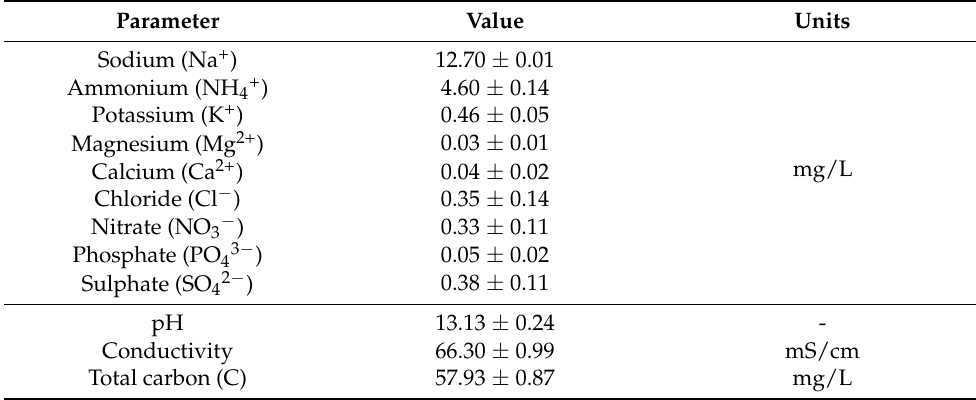
Table 2. Initial sidestream wastewater